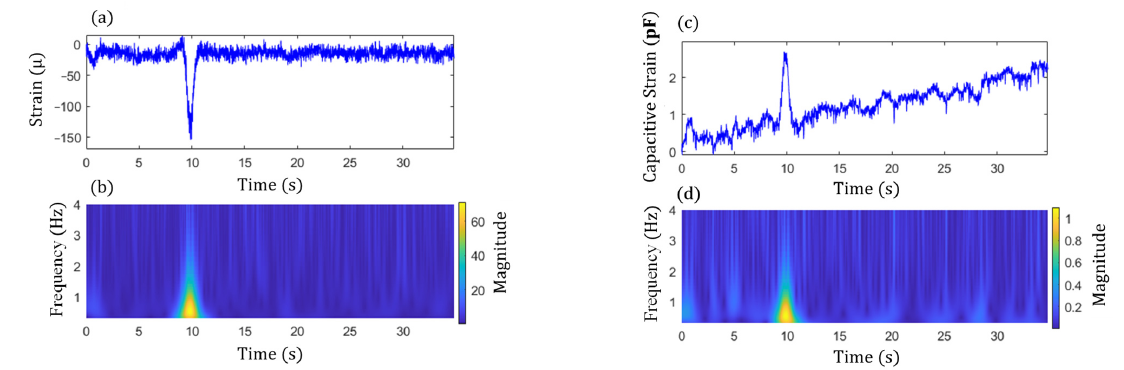
, of cross-frame F , of large-area strain, ∆ C ( t ) C